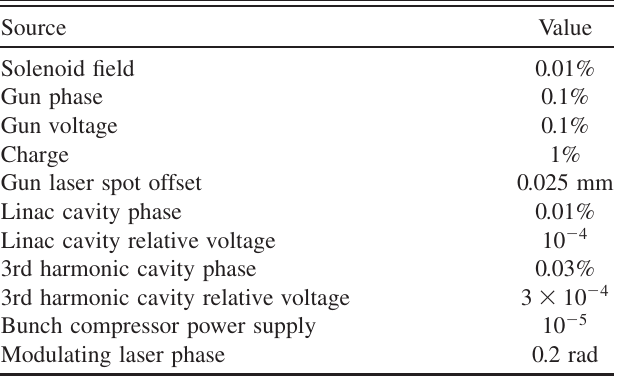
TABLE I. Jitter sources included in the start-to-end tracking simulations (rms values).